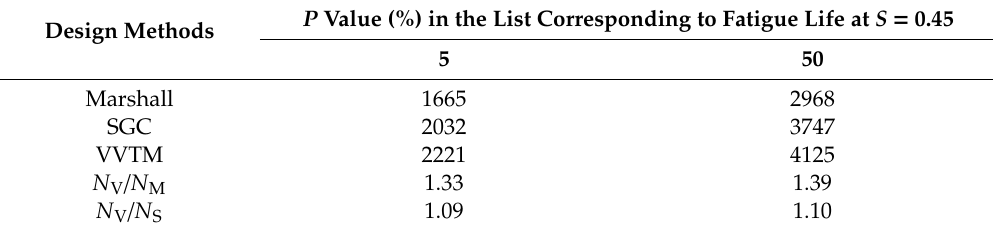
Table 20. Comparison of the fatigue lives of specimens designed by di ff erent methods. Design